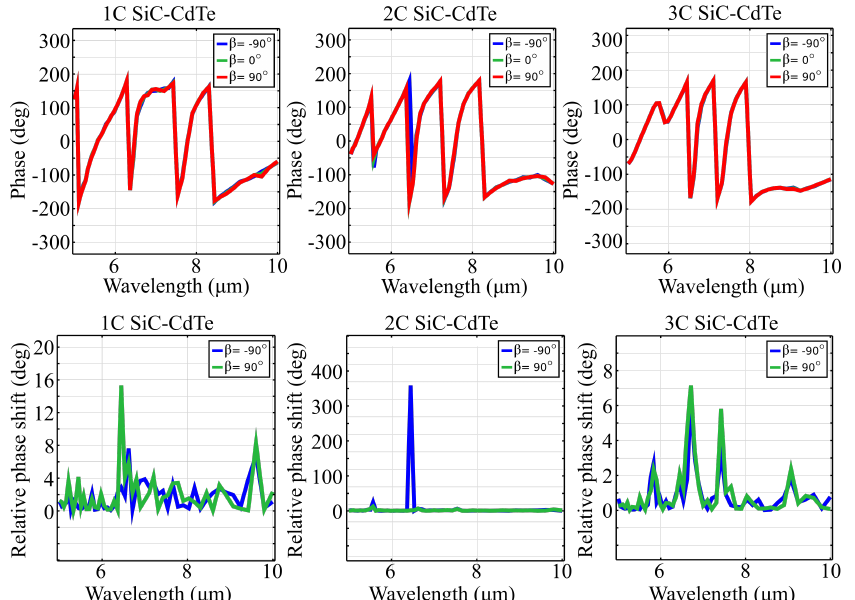
Figure 5. Absolute reflection (top row) and relative reflection (bottom row) spectra of structures 1C, 2C and 3C, under circularly-polarized electric field, at specific values of ellipticity angle β = ± 90 ◦ . The three architectures exhibit relatively low phase variations, with the exception of a small bandwidth where the 2C configuration exhibits a full 2 π phase